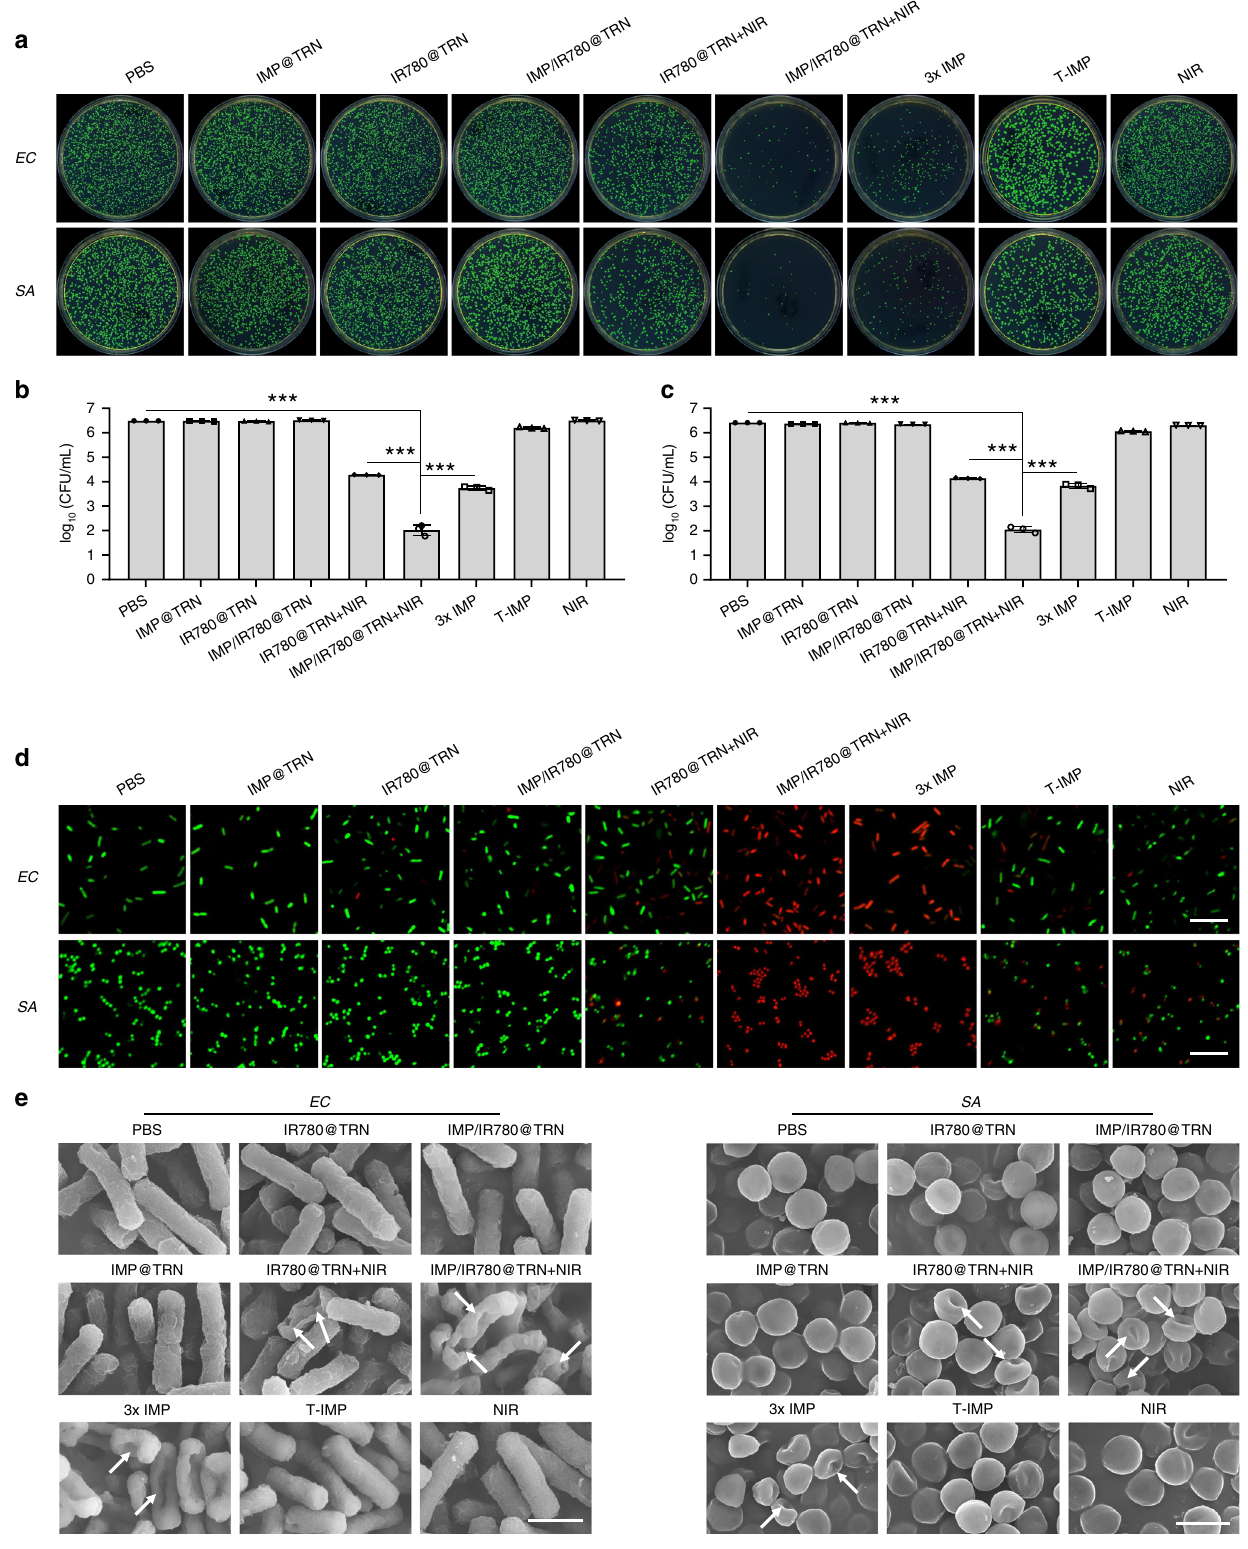
Fig. 4 In vitro antibacterial activities of TRIDENT against antibiotic-sensitive bacteria. a Images of the colonies formed on Luria-Bertani broth-agar plates ( E. − 1 ) for b EC and c SA . Data are presented as mean ± s.d. ( n = 3). coli , EC , and S. aureus , SA ). Statistical analysis of the bacterial cell viability by log 10 (CFU mL ** p < 0.01, *** p < 0.001 (Student ’ s t test). d Images of live (green fl uorescence) and dead (red fl uorescence) bacterial cells following various treatments. Scale bars: 10 μ m. e SEM images of bacteria after treatment with different groups. White arrows denote the morphological damages in bacterial cell. Scale bars: 1 μ m. Source data are provided as a Source Data fi